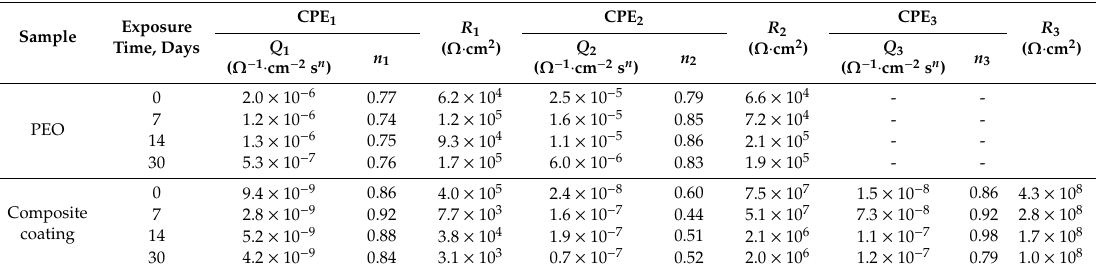
Figure 14. Bode plots obtained in 3% NaCl for PEO and composite coatings before and after 7, 14 and 30 days of atmospheric exposure. ( a ) PEO coatings impedance modulus ( b ) PEO coatings phase angle, ( c ) composite coatings impedance modulus, ( d ) composite coatings phase angle. Table 8. PEO and composite coatings EEC parameters before and after 7, 14 and 30 days of atmospheric exposure (Figure